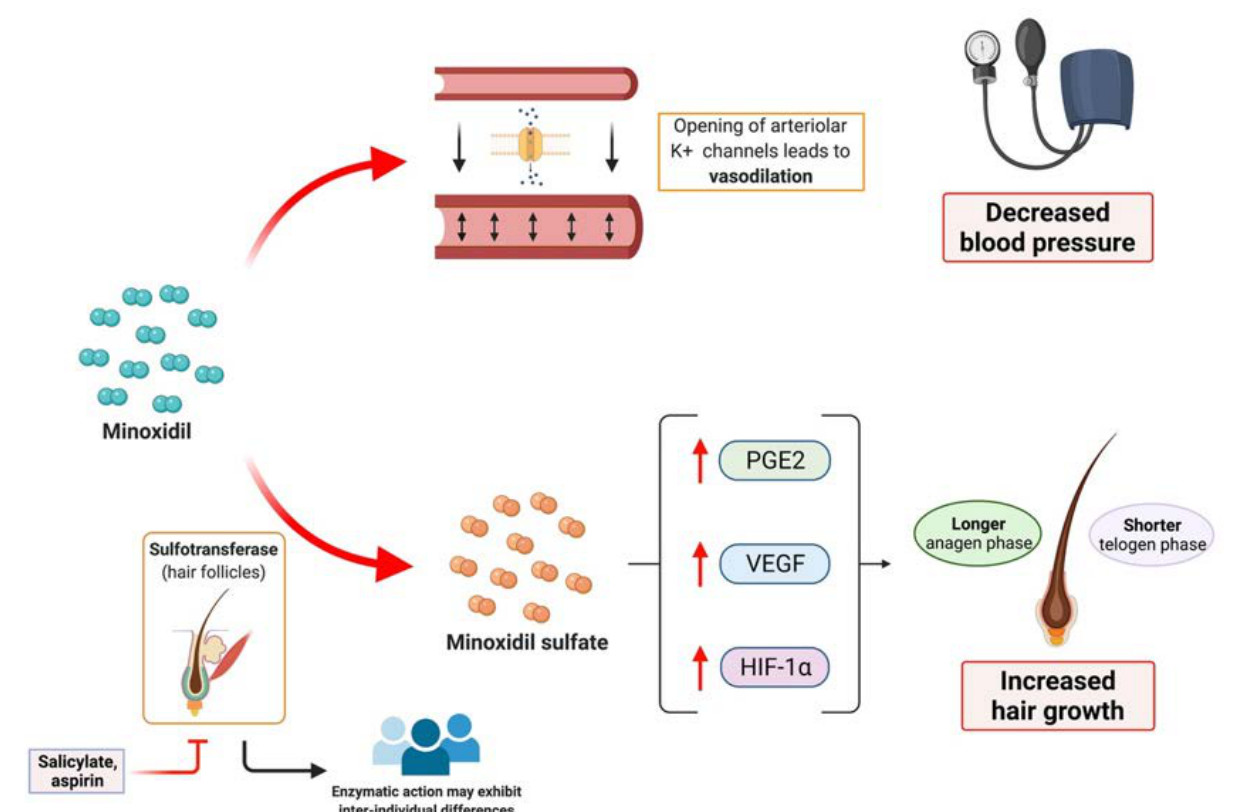
Figure 2. Overview of the mechanism of action of minoxidil. Minoxidil induces the opening of arteriolar potassium channels, leading to vasodilation, which is the basis of its utility regarding the treatment of hypertension. Minoxidil also induces biochemical changes within the hair follicle, such as the increase of vascular endothelial growth factor (VEGF), hypoxia-induced factor 1 alfa (HIG-1alfa) and prostaglandin E2. These changes lead to a longer anagen phase and a shorter telogen phase, inducing an increased hair growth. Sulfotransferase, which can be inhibited by salicylates and aspirin, is responsible for generating minoxidil sulphate, which is the active form of minoxidil within the hair follicles. Inter-individual differences in sulfotransferase could explain the different responses to treatment. Created with BioRender.